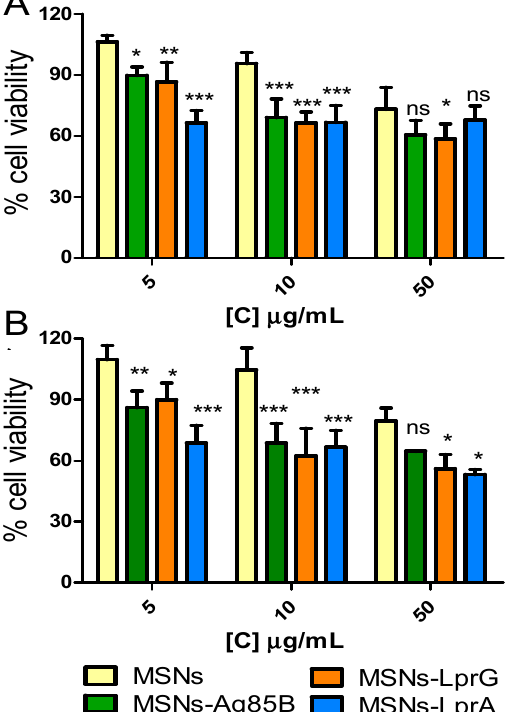
Figure 5. Cell viability of RAW 264.7 cells exposed to different concentrations (5, 10, 50 μ g/mL) of MSNs, MSNs-Ag85B, MSNs-LprG, and MSNs-LprA for ( A ) 24 and ( B ) 48 h ( n = 5). Data were evaluated by ANOVA followed by Bonferroni´s multiple-comparison test. *** p < 0.001, ** p < 0.01, and * p < 0.05 versus cells treated with MSNs; ns, not significant.